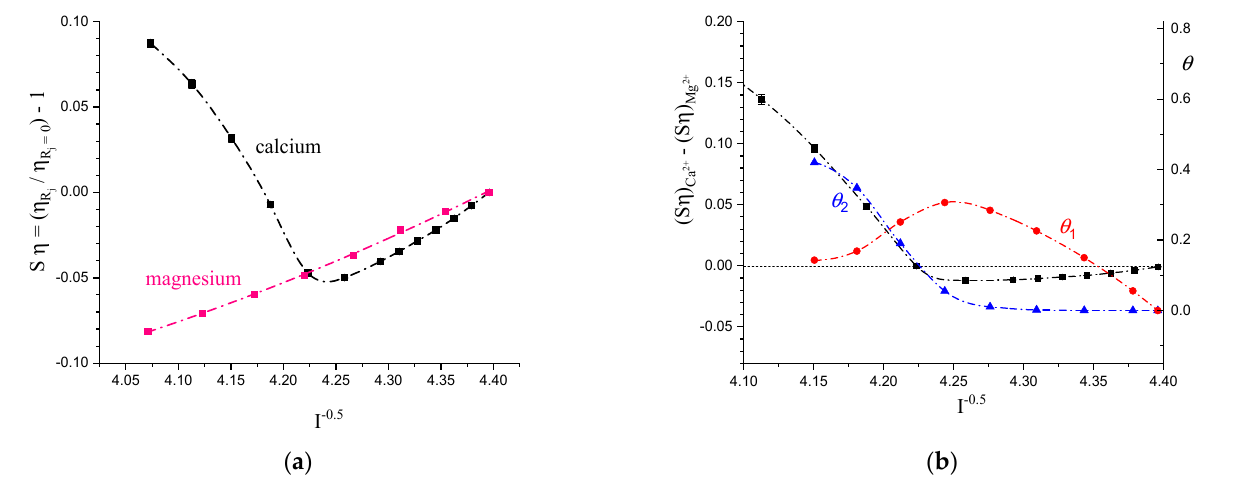
Figure 14. ( a ) Dependence of the relative increase of specific viscosity, S η , on the reciprocal of the square root of the ionic strength, I, for the addition of Ca 2+ ions (black full squares) and Mg 2+ ions (pink full squares) to L. hyp. alginate in aqueous NaCl 0.05 M. ( b ) Black full squares: dependence on the reciprocal of the square root of the ionic strength of the difference of the relative increase of specific viscosity, S η , between the data with Ca 2+ ions and those with Mg 2+ ions of panel ( a ); full symbols and dash-dotted curves: dependence on the reciprocal of the square root of the ionic strength of the fractions of type -1 (red) and type-2 chemically bound Ca 2+ ions to L.hyp. alginate, respectively (r.h.s. ordinate).